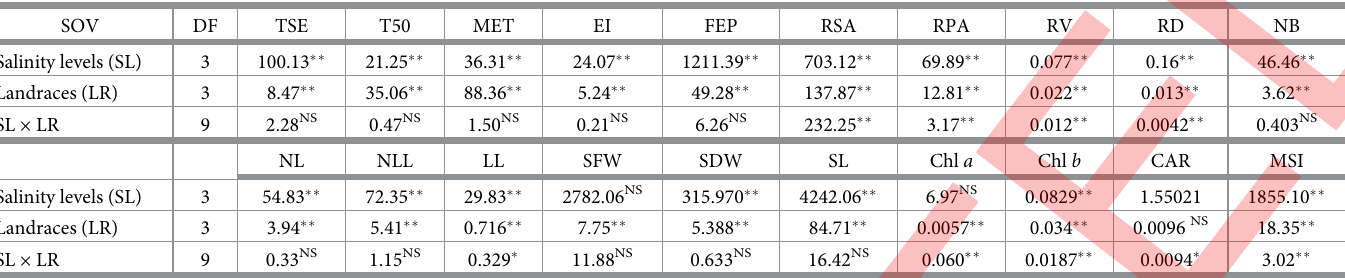
and final emergence percentage) of all moringa landraces at various extent. Overall, at highest salinity level (11.5 dS m -1 ), moringa seeds took maximum time for emergence than at control (lowest salinity level; 1.5 dSm -1 ). Similarly, emergence index (EI) and final emergence percent- age (FEP) were also recorded best at lowest salinity level as compared to highest salinity level. Moreover, all moringa landraces showed different emergence rate at different salinity level, thus maximum emergence attributes were recorded in MFB followed by MPB, MFW and MRB (Fig 1). The effect of various salinity levels (1.5, 3.5, 7.5 and 11.5 dSm -1 ) was observed on morpho- logical attributes of moringa landraces (MFB, MPB, MFW, MRB). Data recorded for seedling fresh weight demonstrated that all moringa landraces showed maximum fresh biomass at mini- mum salinity level (1.5 dS m -1 ), while least seedling fresh weight was observed at highest salinity level (11.5 dS m -1 ). Similarly, the results obtained for seedling dry weight was showed that among different moringa landraces maximum seedling dry weight was noted at 1.5 dS m -1 salinity level, while least was observed at 11.5 dS m -1 salinity level. However, the order of improvement of seedling dry weight among landraces was: MBR > MPB > MFW > MFB. Data, recorded for seedling length, showed significant difference between moringa landraces and salinity levels but their interaction was non-significant. Among the salinity levels the plant showed the maximum seedling length at minimum salinity level (1.5 dS m -1 ), while the maxi- mum seedling length of MBR landrace was noted as compared to other landraces. However, at highest salinity level (11.5 dS m -1 ) maximum reduction in seedling length was recorded (Fig 2). Data, recorded for chlorophyll contents, showed that salinity levels decreased the chloro- phyll a content of all landraces. All the landraces showed different behavior under salinity lev- els, the order reduction among all moringa landraces at 1.5 dS m -1 salinity level was: MPB > MFB > MRB > MFW, while order of reduction at 3.5 dS m -1 was: MFB > MBP > MFW > MRB, at 7.5 dS m -1 salinity level reduction order was: MRB > MFB > MFW > MPB, similar at 11.5 dS m -1 salinity level reduction order was: MFW > MRB > MPB > MFB. Thus overall, maximum chlorophyll a content was noted in MFW landrace and MPB synthesized minimum chlorophyll a pigment. Moreover, data recorded for chlorophyll b showed that among all moringa landraces, maximum chlorophyll b pigments were observed in MFW while MBP had minimum chlorophyll b contents. Results obtained for carotenoids concentration showed that among moringa landraces, MRB showed maximum carotenoids while MFW